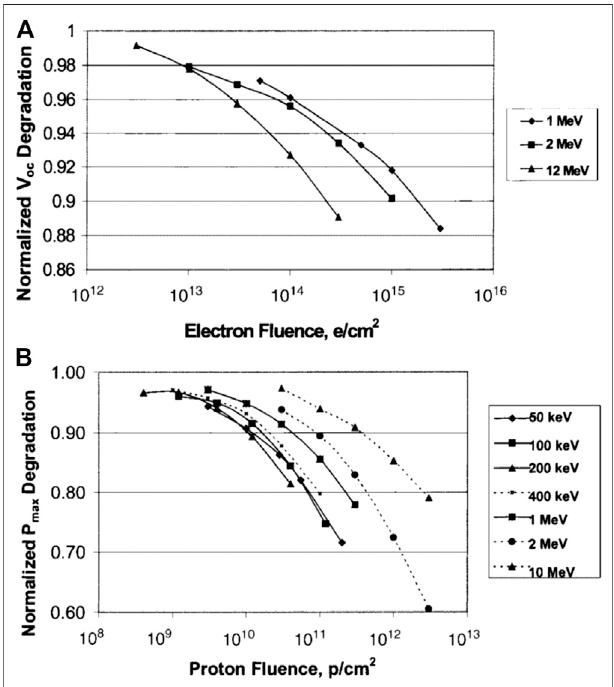
FIGURE5 | The normalized P max degradation oflattice-matched GaInP/ GaAs/Ge solar cells under different (A) electrons and (B) protons irradiation with different particle fl uence [91].